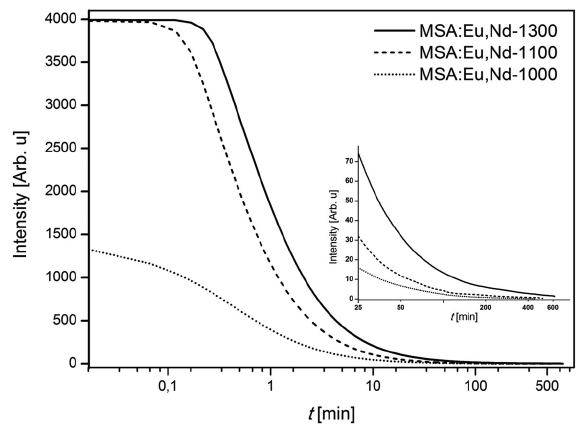
Figure 5. Persistent luminescence lifetimes of samples with the no- minal formula MSA:0.5Eu 2+ ,0.25Nd 3+ , measured at room tempera- ture. The inset graph is a magnification of the tails of the curves. The legend of the curves is ordered by appearance.